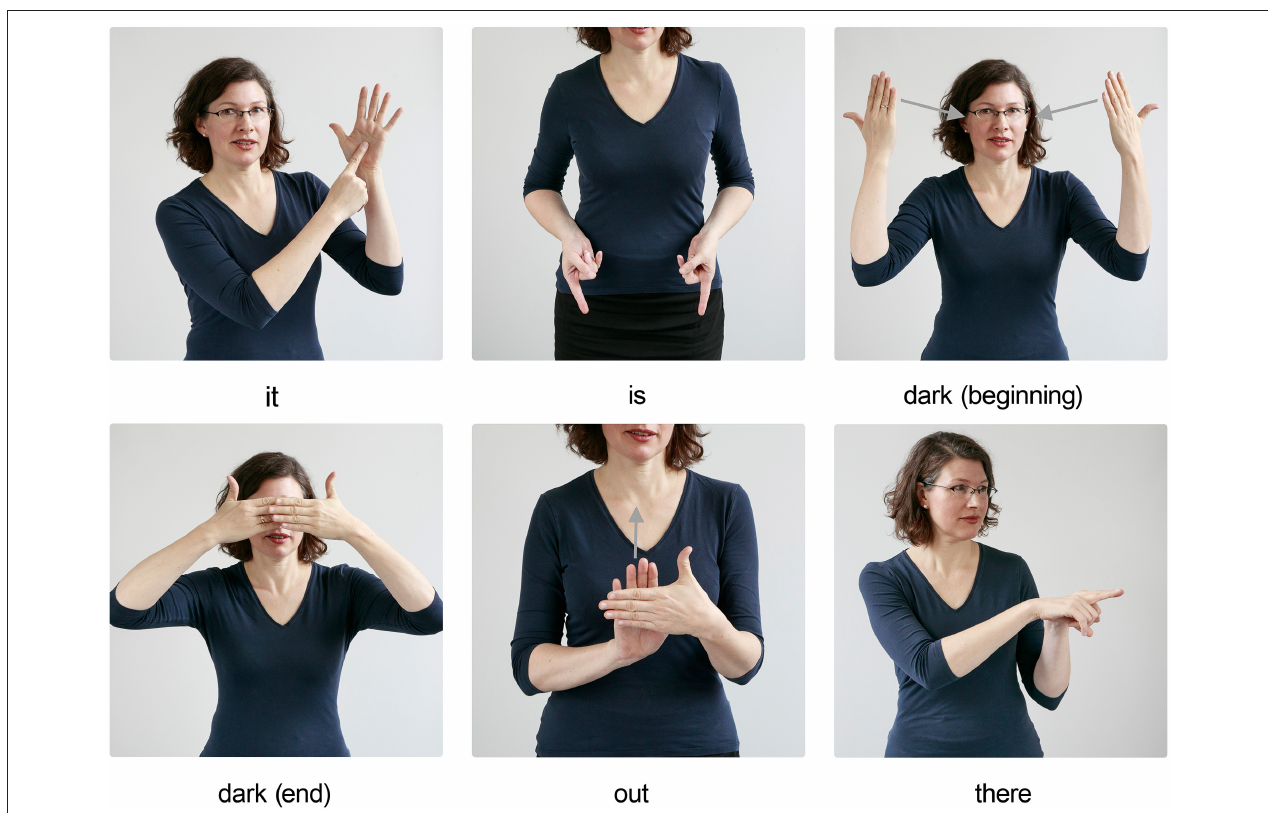
FIGURE 1 | Sample gestures for the sentence It is dark out there in the codified gesture (CG)